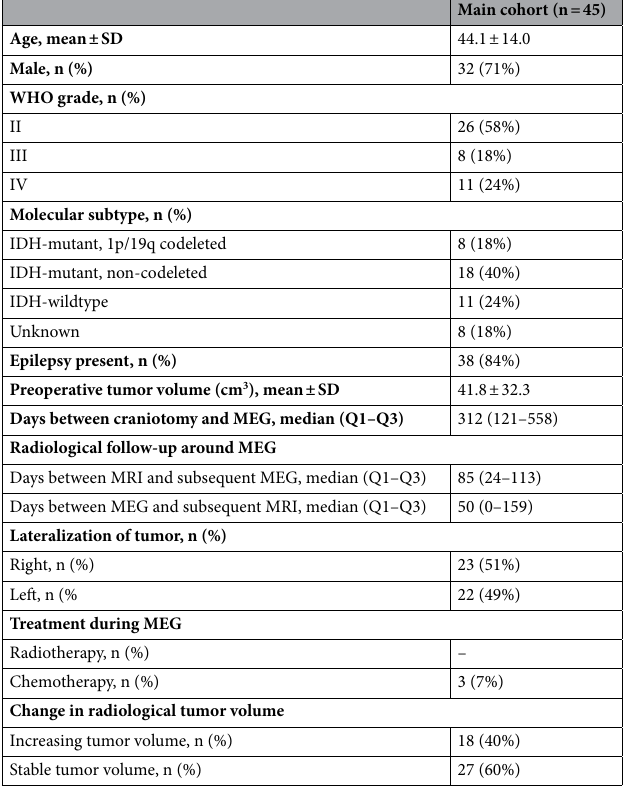
Table 1. Patient characteristics. SD standard deviation, Q1–Q3 1st quartile–3rd